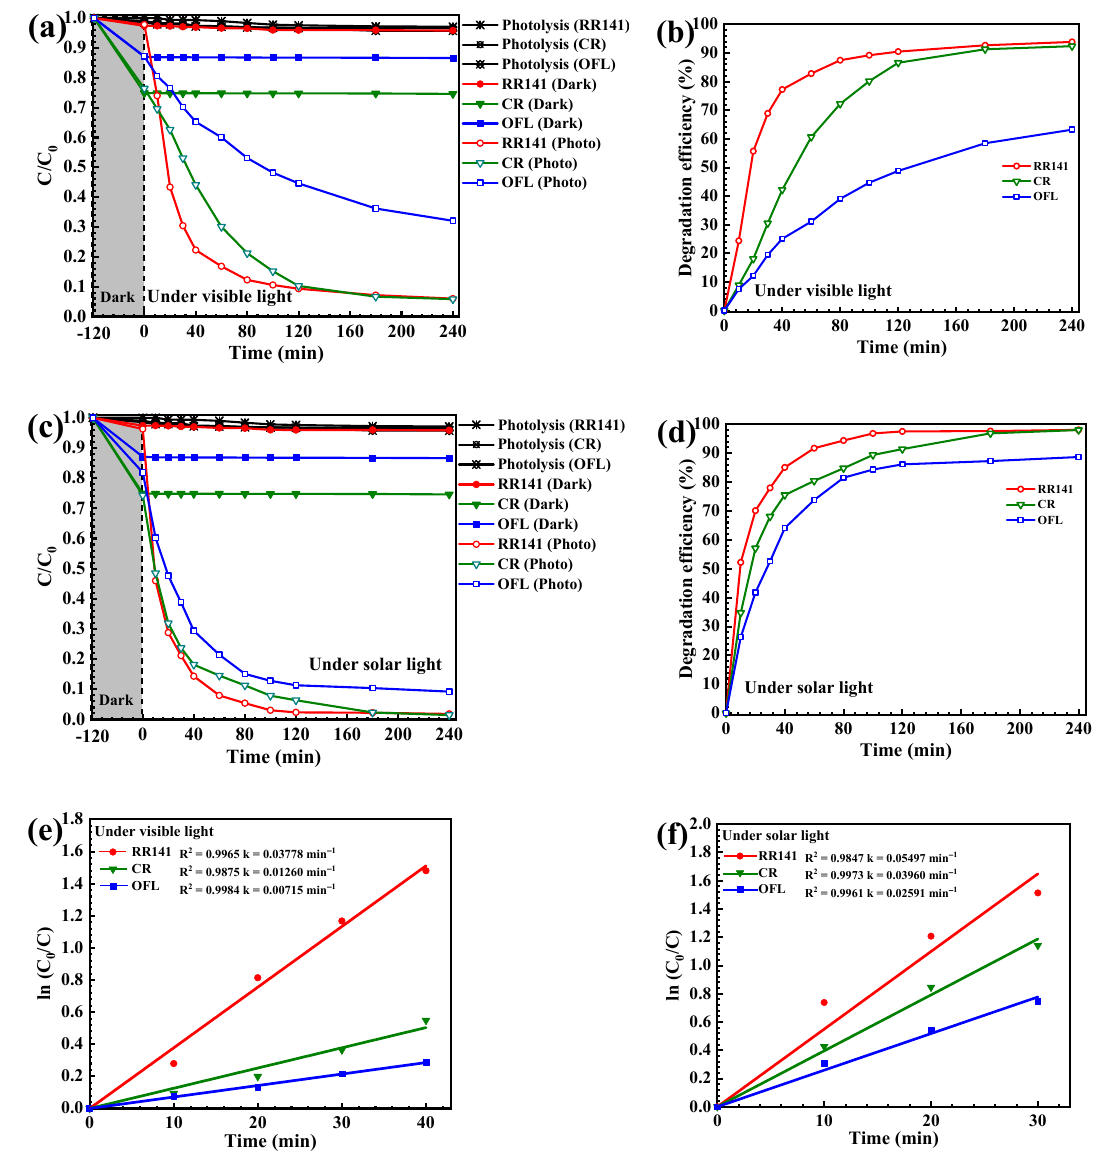
Figure 6. Lowering of the RR141, CR dyes, and OFL antibiotic concentration in the presence of CdS nanoparticles under visible light irradiation ( a ) and solar light irradiation ( c ). Photodegradation efficiency of CdS nanoparticles toward photodegradation of RR141, CR dyes, and OFL antibiotic under visible irradiation ( b ) and solar light irradiation ( d ). A linear plot of ln(C 0 /C) vs. irradiation time toward photodegradation of RR141, CR dyes, and OFL antibiotic under visible light irradiation ( e ) and solar light irradiation ( f ).